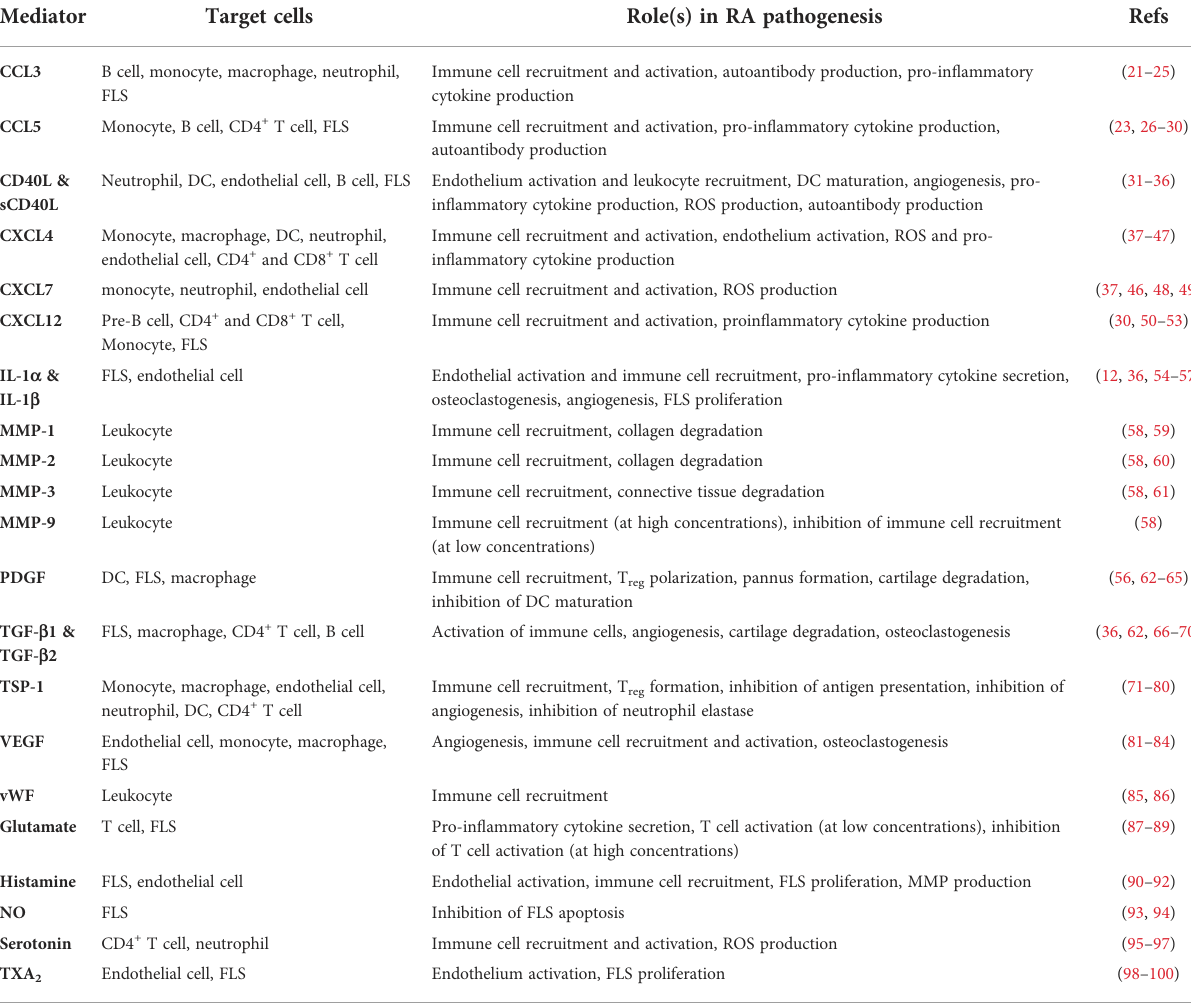
TABLE 1 Platelet-derived mediators with documented role(s) in RA